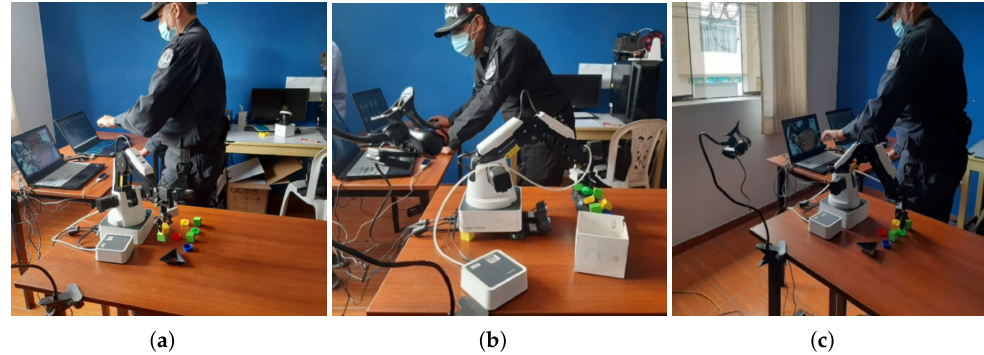
Figure 11. Tests performed in a laboratory environment. ( a ) Tests with the NUI interface and buttons, configuration A. ( b ) Tests with the multimodal interface, configuration B. ( c ) Tests with the button interface, configuration C.